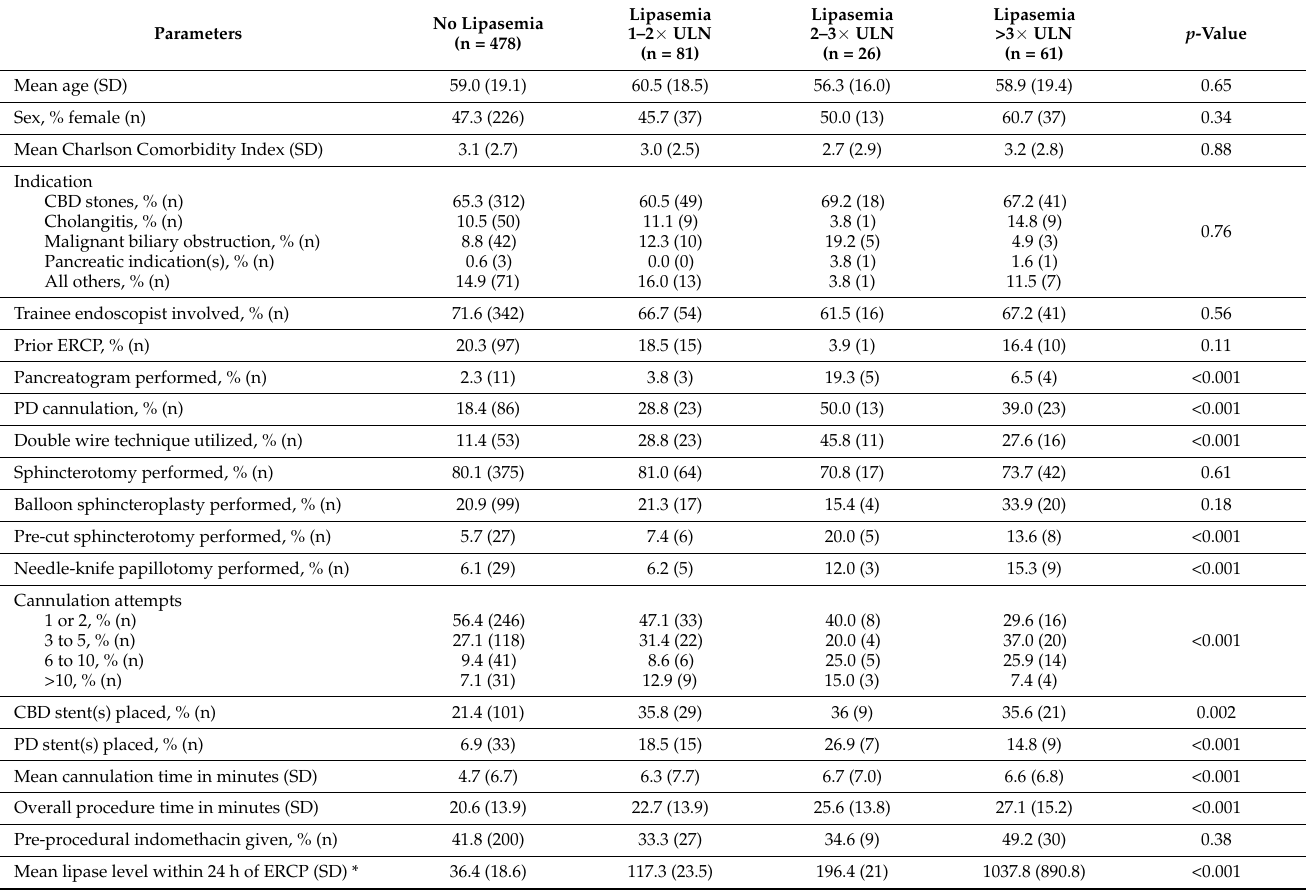
Table 1. Demographic, clinical and procedural details for patients with and without asymptomatic lipasemia after